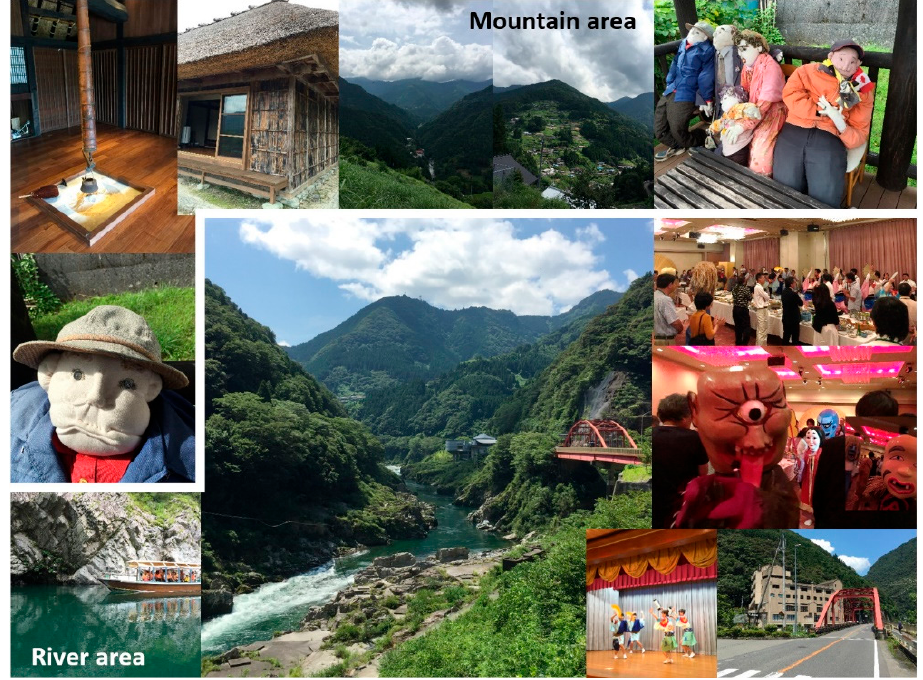
Figure 5. Challenge of an expiring, nearly extinct community in a rural mountain area of Japan.